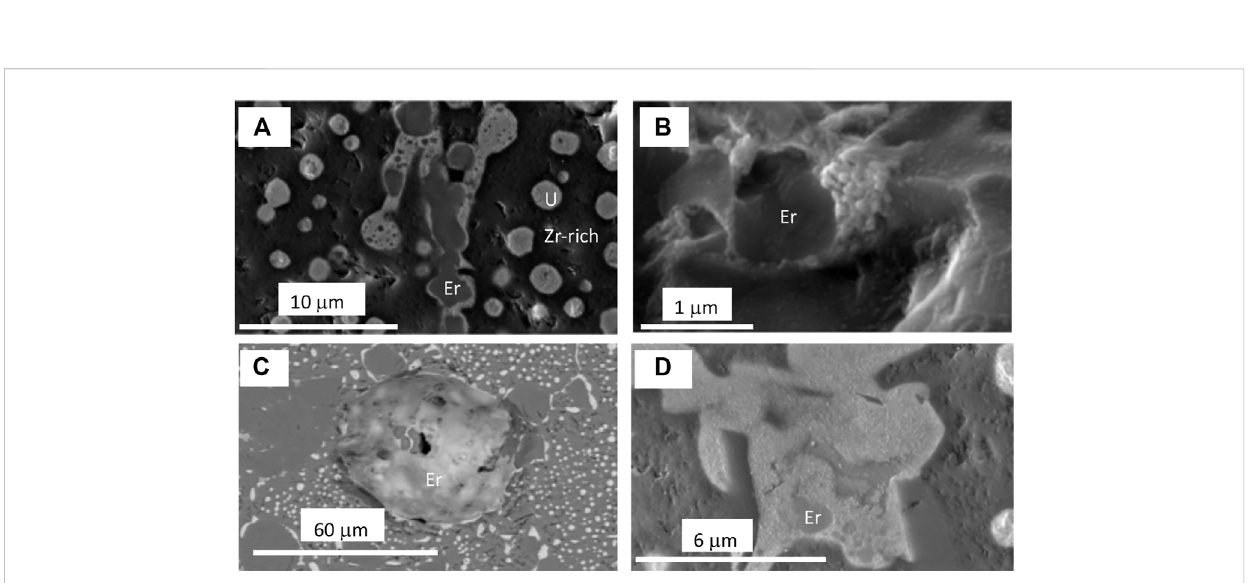
BSE images (A – D) showing examples of fuel meat phases that contain Er. The image in (B) is from a location where a fracture surface was found in the